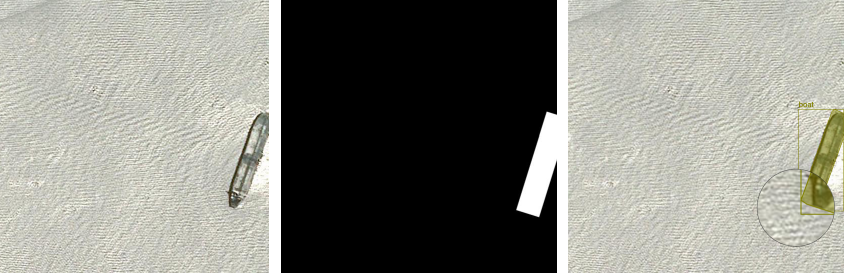
Figure 9. Airbus Ship Detection dataset ground truth annotation example. Left: original image; Middle: ground truth annotation mask. Right: magnified detail showing the discrepancy between the mask and the true ship segmentation.